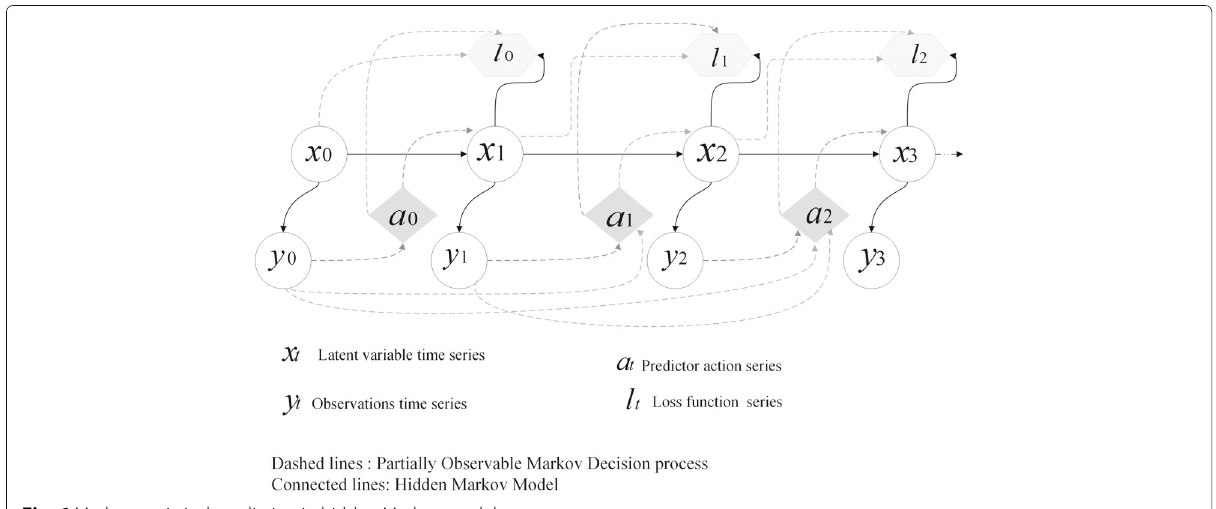
Fig. 6 Markov statistical prediction in hidden Markov